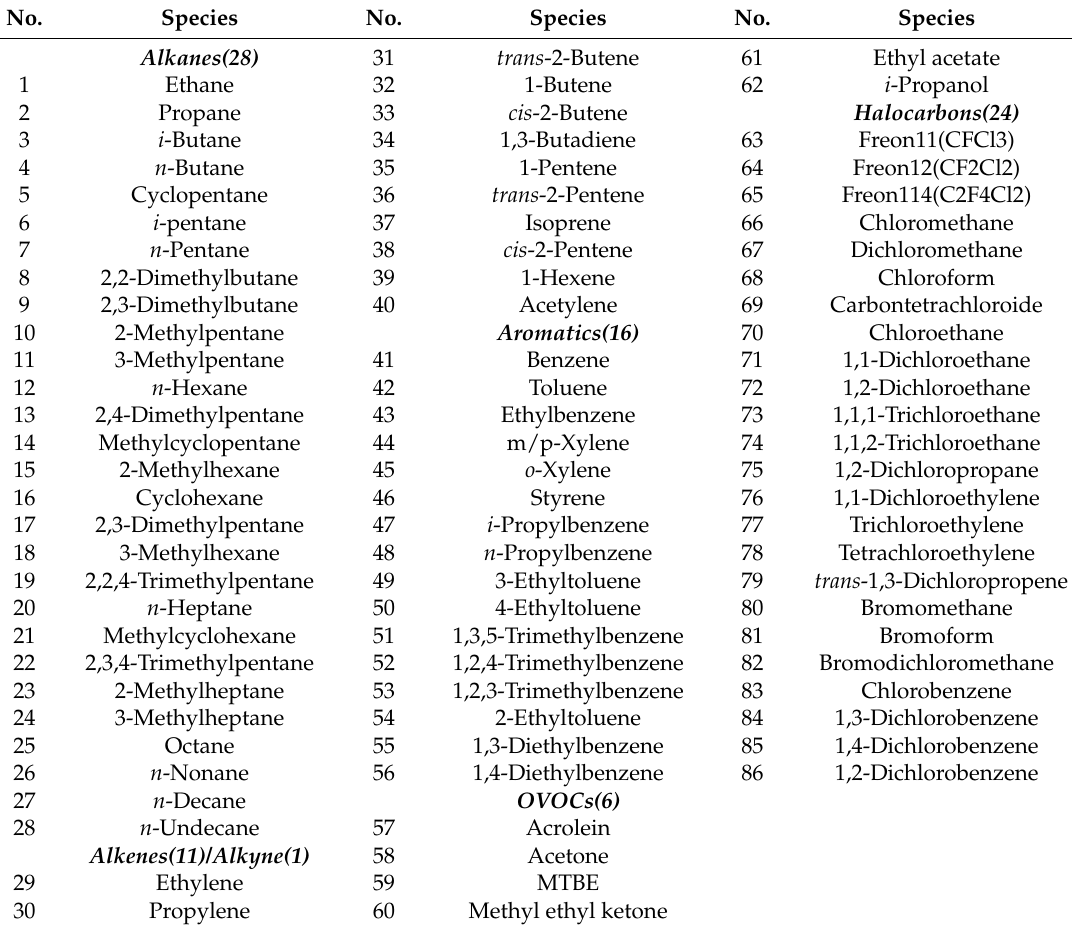
Table 1. Volatile organic compound (VOC) species measured in emission